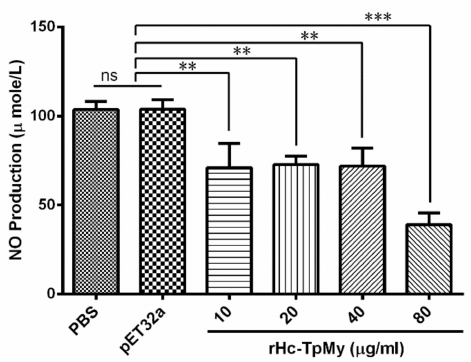
Figure 6. Impacts of rHc-TpMy on nitric oxide production. PBMCs were cultured with di ff erential concentrations of rHc-TpMy protein, pET32a protein or control bu ff er (PBS), and intracellular nitrite concentration in the PBMCs was measured by using Griess assay. PBMCs used for all replicates of distinct treatments in each experimental repetition were derived from the same goat. The data are presented as the mean ± SD and representative of three independent experiments (** p < 0.01 and *** p < 0.001, and ns: non-significant).